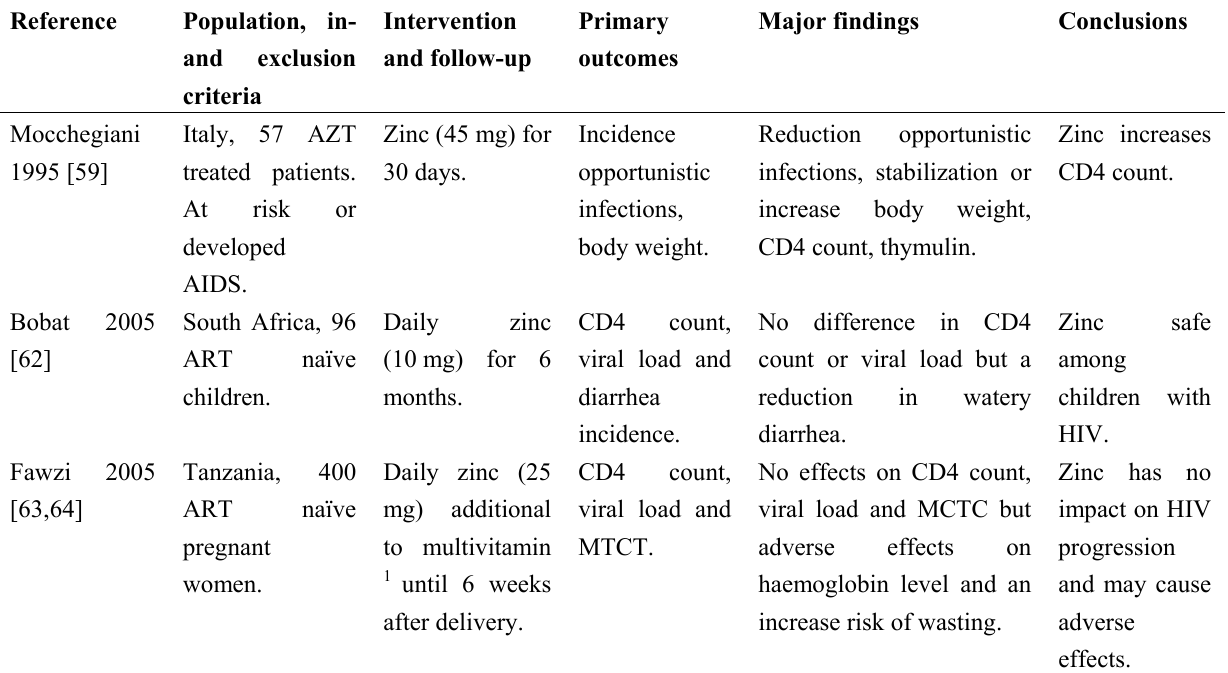
Table 4. Randomized controlled trials on zinc and HIV